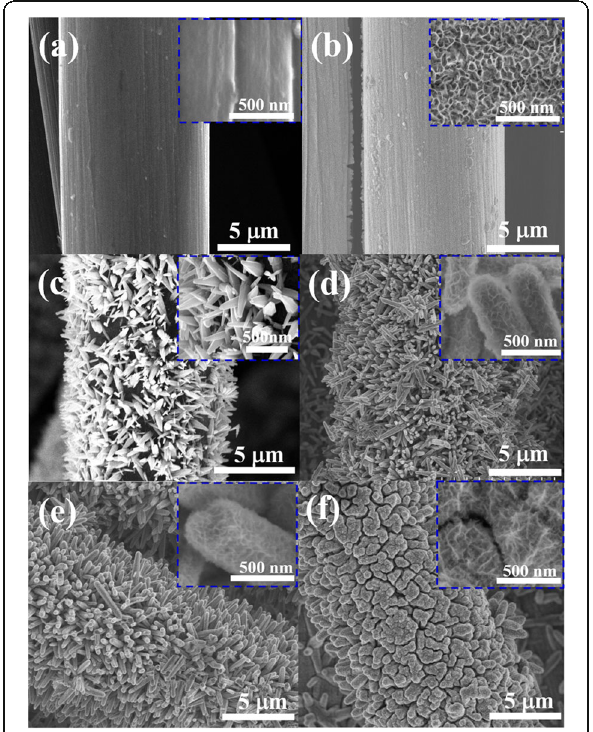
Fig. 3 SEM images of a carbon cloth, b NiO nanosheets, c ZnO nanorods, d ZN1, e ZN2, and f